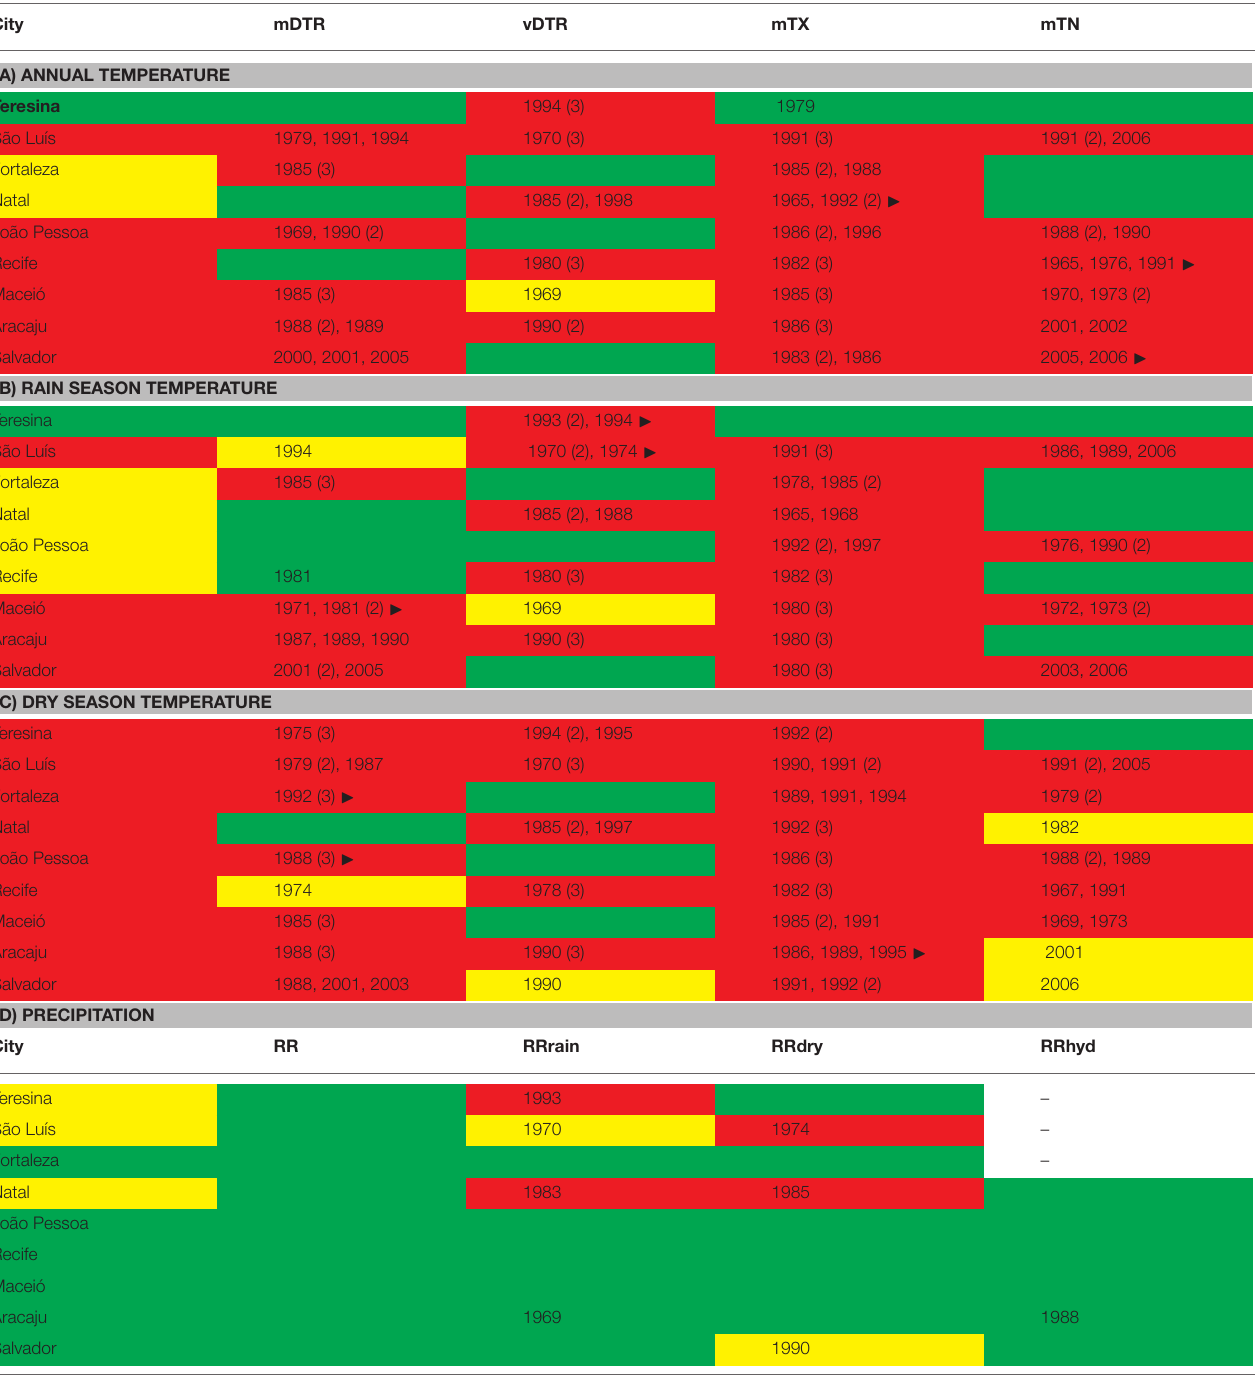
TABLE 2 | Break year identified by the homogeneity tests for (A) yearly, (B) rain season, and (C) dry season temperatures as well as (D) precipitation totals including homogeneity classification (green, useful; yellow, doubtful; red,